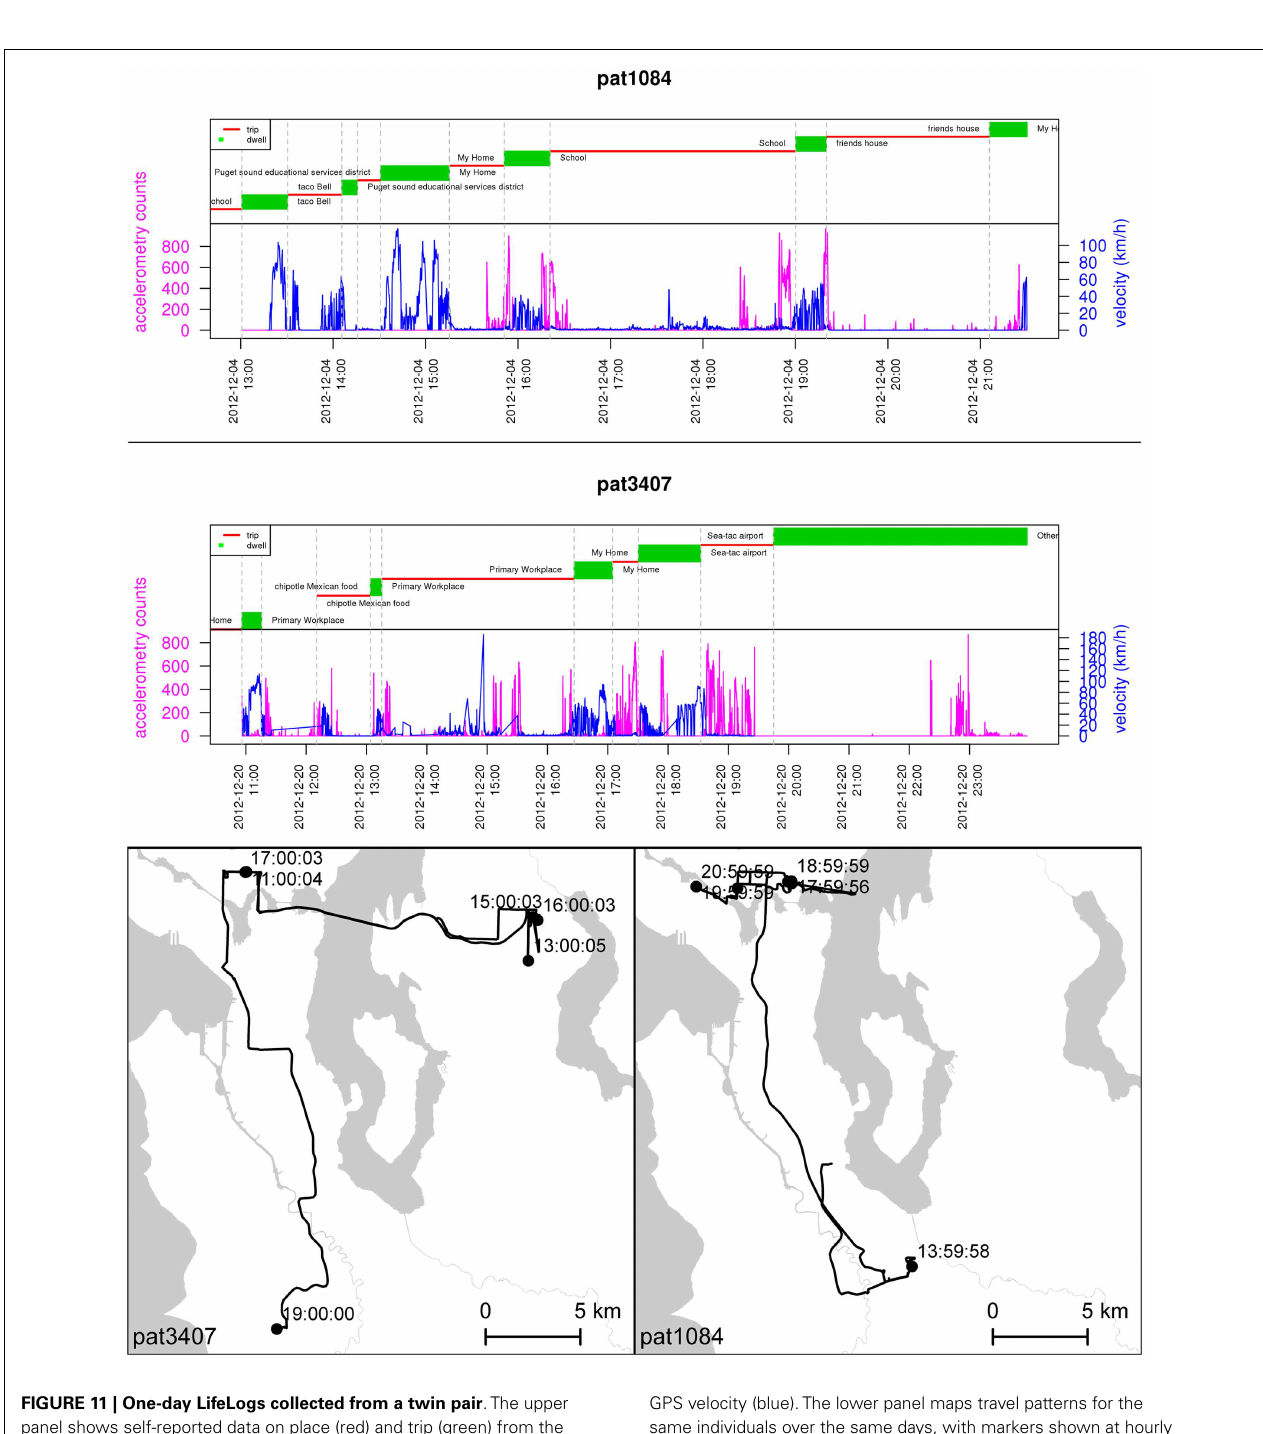
FIGURE 11 | One-day LifeLogs collected from a twin pair .The upper panel shows self-reported data on place (red) and trip (green) from the travel diary along with objective accelerometry counts (magenta) and